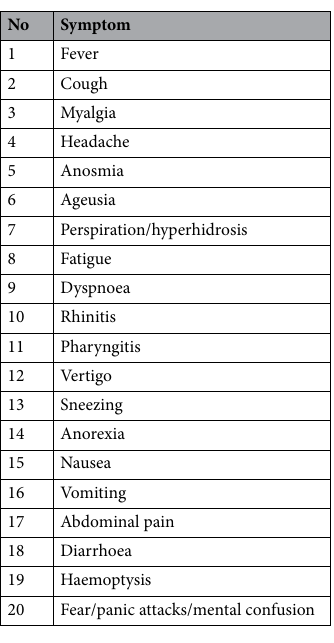
Table 2. strates relationship between SARS-CoV-2 VL and reversed PaO 2 /FiO 2 ratio (the first item in the formula for ARDS score AS , see “Methods” section). We can observe that there is no clear correlation between reversed PaO 2 /FiO 2 ratio and VL for the whole range of VLs. None the less, the almost linear piecewise dependence of reversed PaO 2 /FiO 2 ratio on SARS-CoV-2 VL (several linear fragments) helps to isolate asymptomatic carriers (the leftmost points in Fig. 1) and severest cases (the rightmost points), whereas the majority of VLs corresponds to approximately the same reversed PaO 2 / FiO 2 ratio = 3.6 ± 1.3 mmHg –1 (horizontal plateau in the middle of Fig. 1). That corresponds to direct PaO 2 /FiO 2 ratio range = [204…434 mmHg].